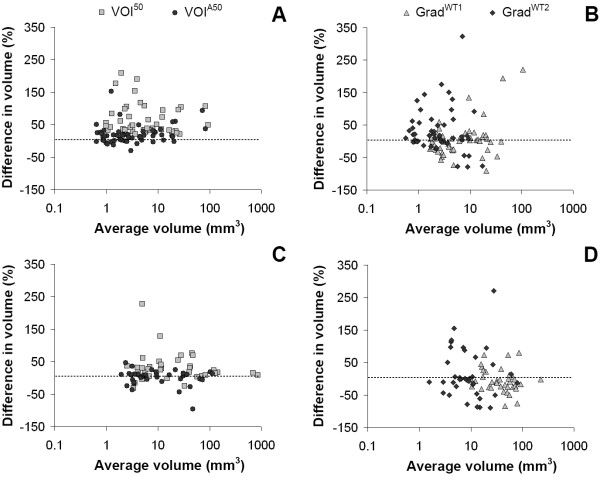
Percentage difference in measured volumes compared to the measured volume. Percentage difference in measured volumes compared to the measured volume derived from SUV and Patlak images for various delineation methods applied to (A, B) NSCLC and (C, D) GI cancer. Note that some data points (for VOI50 and GradWT2) fall outside the range of the figure. The percentage difference was defined as VolumeSUVVolumePatlak - 1×100%.